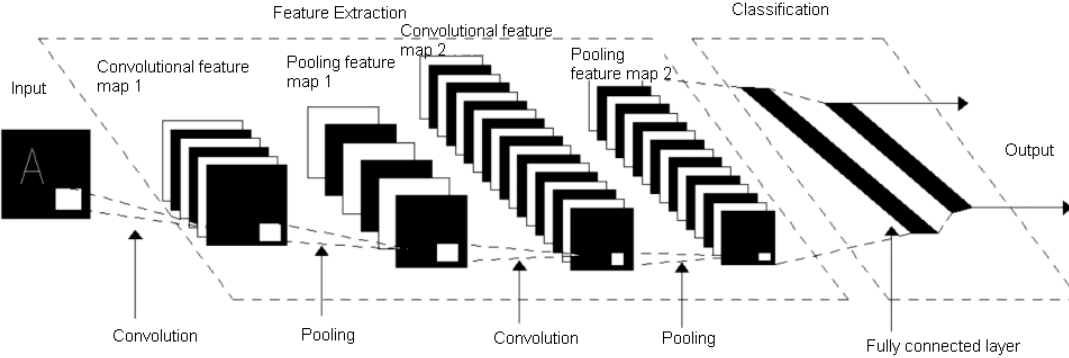
Figure 2. Convolution neural network (CNN) structure diagram.